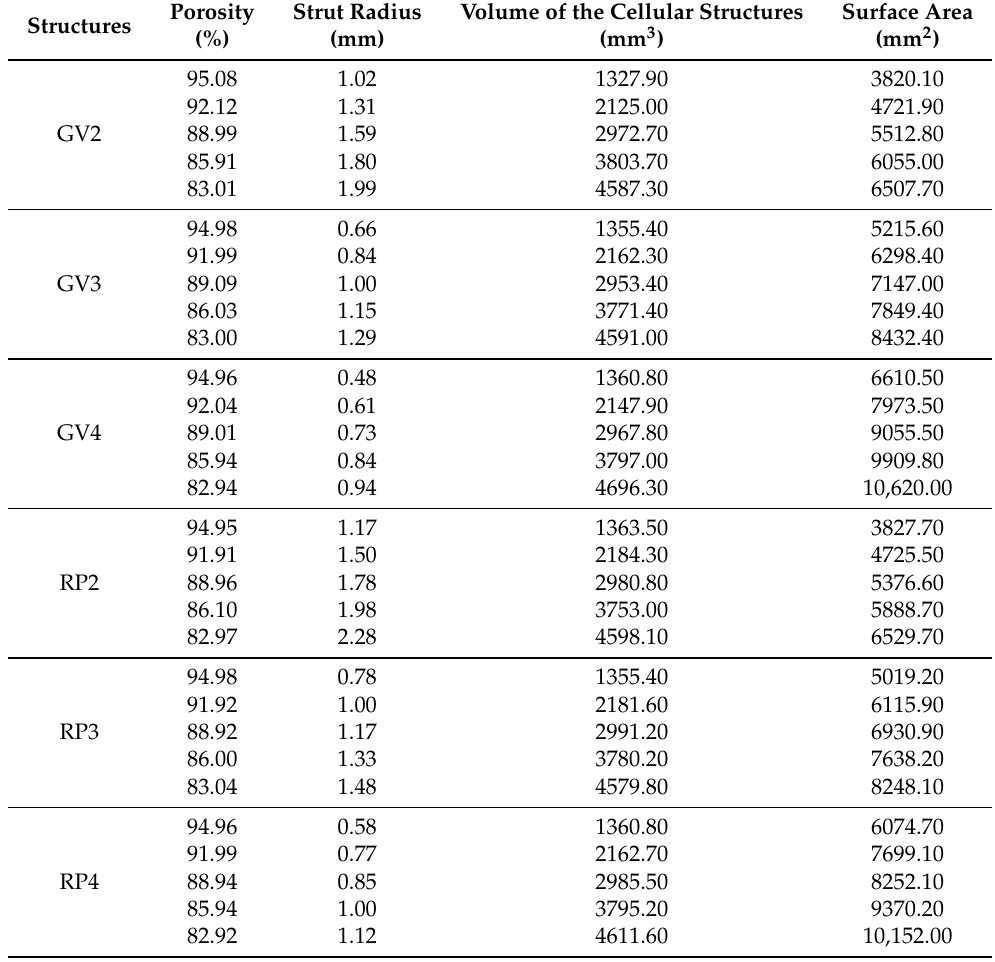
Figure 3. Regular porous structure: ( a ) Regular porous structure consisting of 2 × 2 × 2 units (RP2). ( b ) Regular porous structure consisting of 3 × 3 × 3 units (RP3). ( c ) Regular porous structure consisting of 4 × 4 × 4 units (RP4). Table 2. Specific geometric parameters of the porous structure. Structures